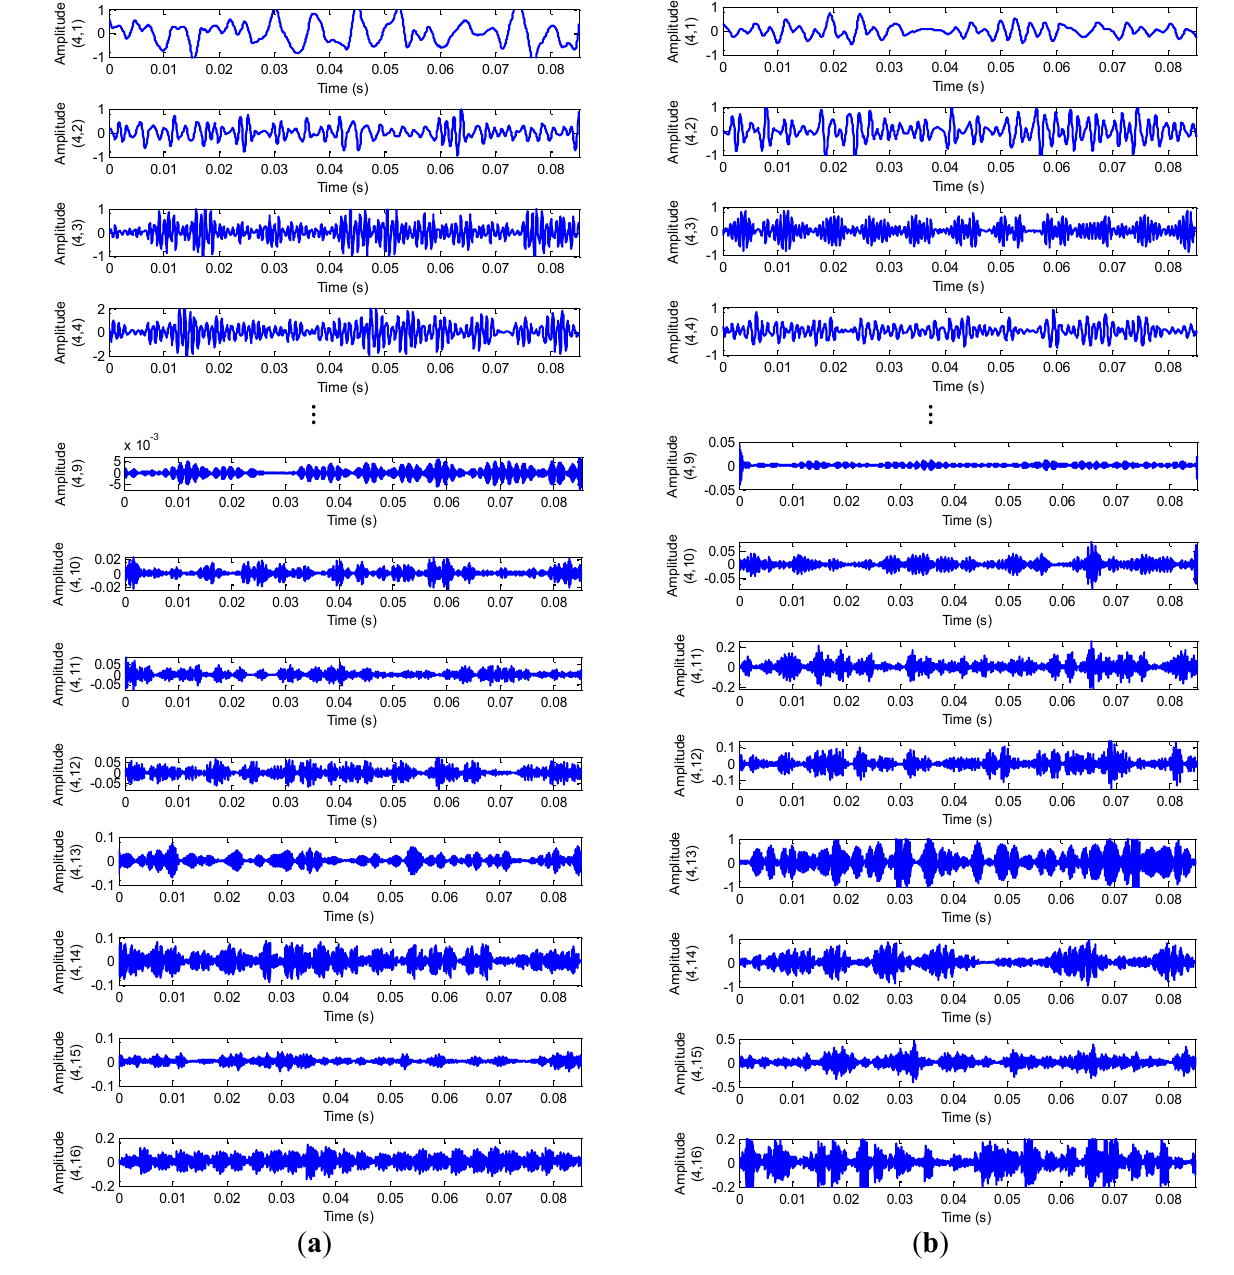
Figure 9. The signals of the decomposed by WPT from: ( a ) the normal bearing. ( b ) the ball fault